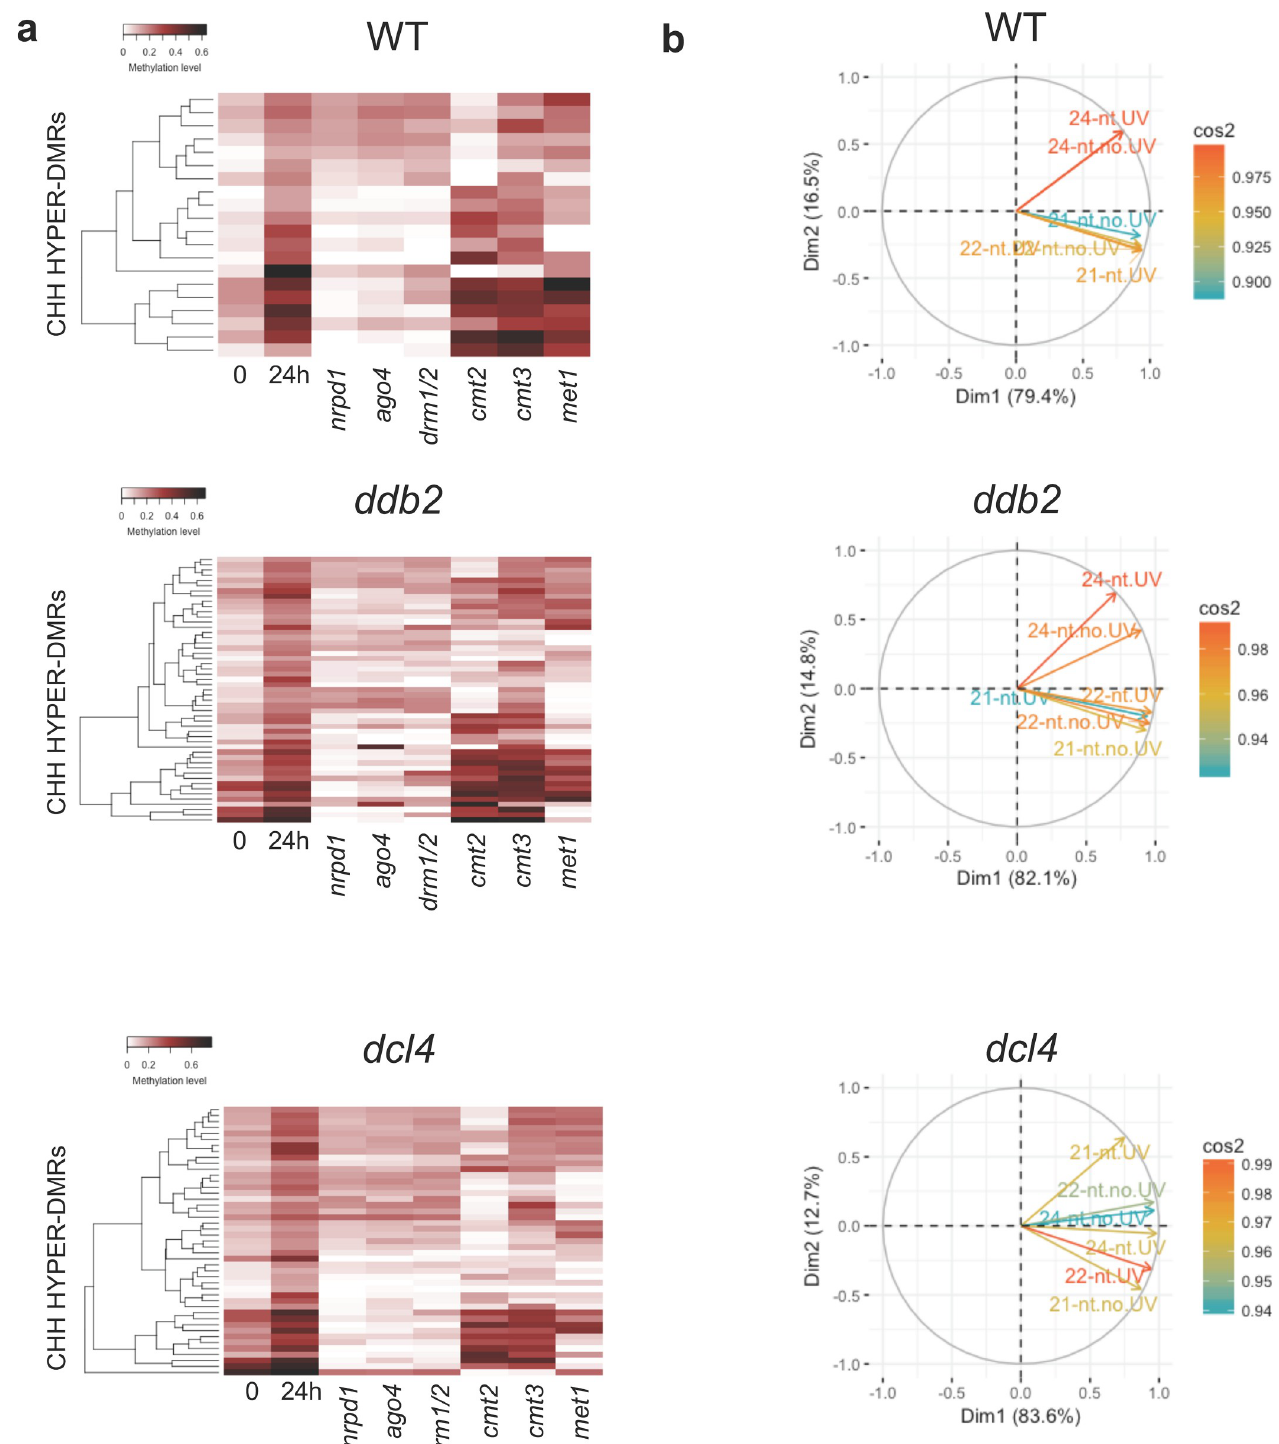
Fig 7. Characteristics of hyper-DMRs overlapping with photolesions. a Heatmaps of CHH methylation levels within hyper-DMRs identified in WT, ddb2 and dcl4 plants before, 24h upon UV-C exposure. Columns represent data for each indicated genotype (white, 0; black, 0.6) b Circles of correlations between 21-, 22- and 24-nt small RNAs mapping to the hyper-DMRs overlapping with photolesions in WT, ddb2 and dcl4 plants.